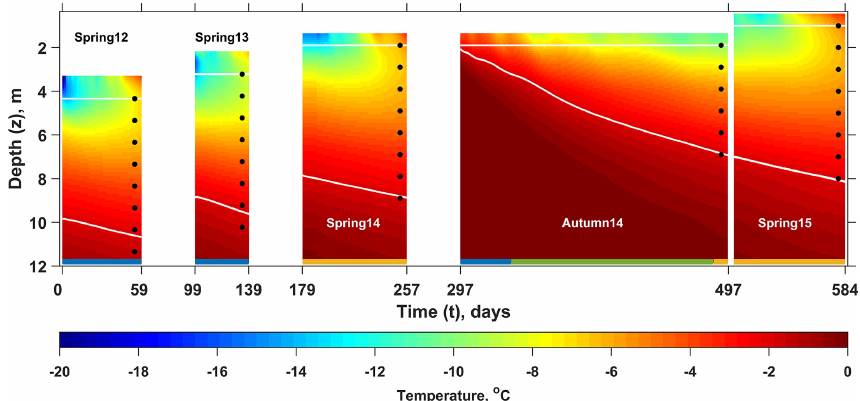
Figure 2. Measured evolution of subsurface temperature. The vertical axis is referenced to the glacier surface in April 2015. The horizontal axis is referenced to 21 April 2012 and is linear for the periods covered by measurements: 21 April–19 June 2012 (“spring 2012”), 22 April– 1 June 2013 (“spring 2013”), 18 April–4 July 2014 (“spring 2014”), 25 September 2014–11 April 2015 (“autumn 2014”), and 15 April–9 July 2015 (“spring 2015”) and arbitrary between the domains. White curves indicate the upper and lower boundaries of the simulation domains. The colour bars along the horizontal axis show the intervals between measurements: yellow – 1h, blue – 3h and green –